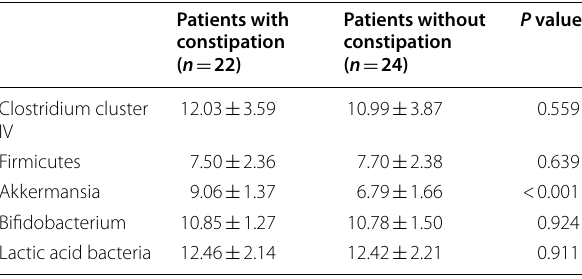
Table 6 Copy number of gut microbiota among PD with constipation versus patients without constipation Patients with